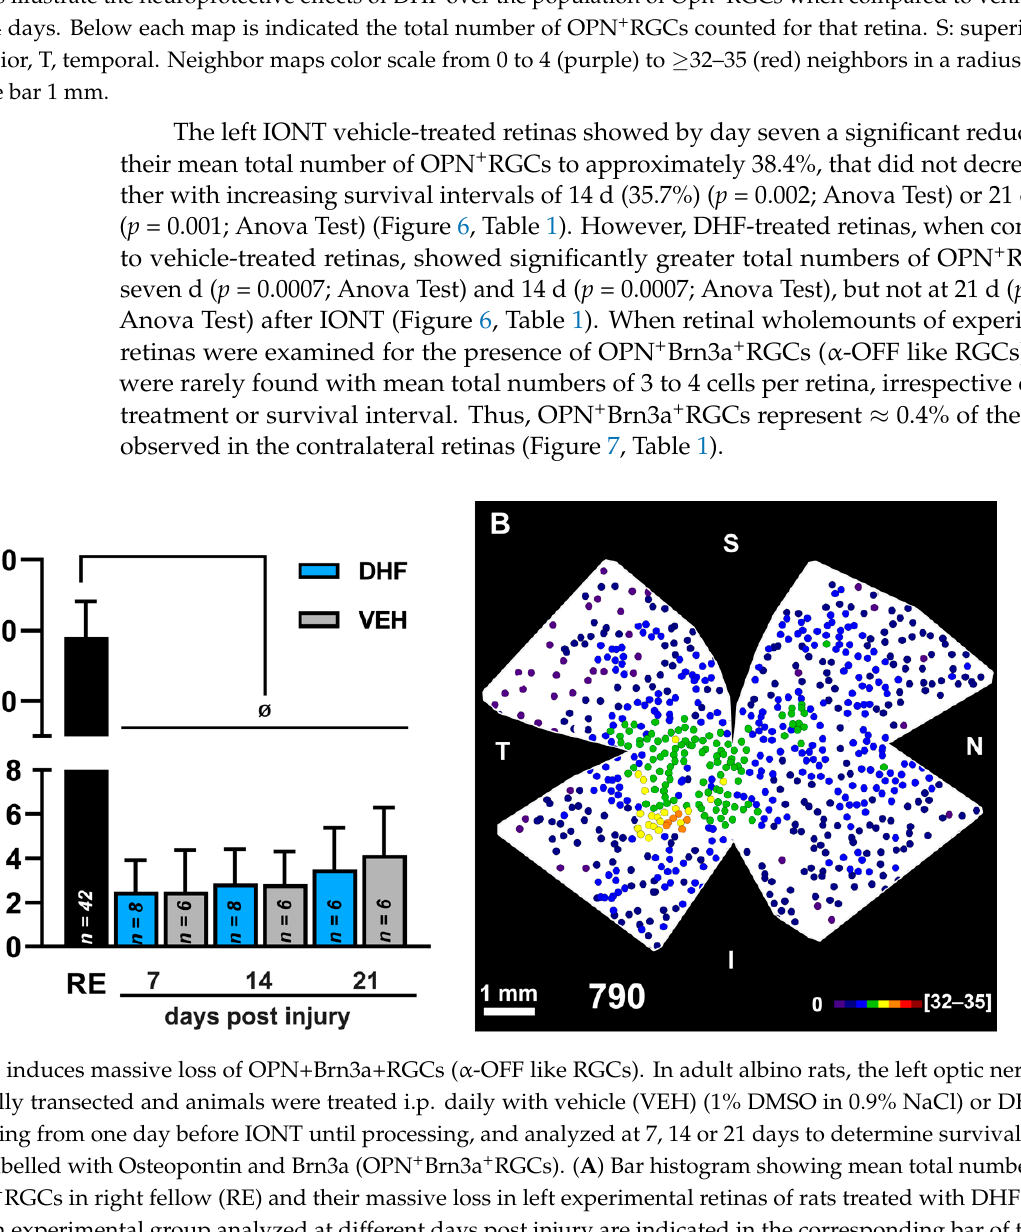
Figure 7. IONT induces massive loss of OPN+Brn3a+RGCs ( α -OFF like RGCs). In adult albino rats, the left optic nerve was intraorbitally transected and animals were treated i.p. daily with vehicle (VEH) (1% DMSO in 0.9% NaCl) or DHF (5 mg/kg) starting from one day before IONT until processing, and analyzed at 7, 14 or 21 days to determine survival of RGCs double labelled with Osteopontin and Brn3a (OPN + Brn3a + RGCs). ( A ) Bar histogram showing mean total numbers of OPN + Brn3a + RGCs in right fellow (RE) and their massive loss in left experimental retinas of rats treated with DHF or VEH ( n for each experimental group analyzed at different days post injury are indicated in the corresponding bar of the histogram). One-way ANOVA Ø p < 0.05, differences between control and the experimental groups. ( B ) Representative neighbor map showing OPN + Brn3a + RGCs topography in an untouched contralateral retina. Below the map is indicated the total number of OPN + Brn3a + RGCs counted for that retina. S: superior, N: nasal, I inferior, T, temporal. Neighbor maps color scale from 0 to 4 (purple) to ≥ 32–35 (red) neighbors in a radius of 0.276 mm. Scale bar 1 mm.